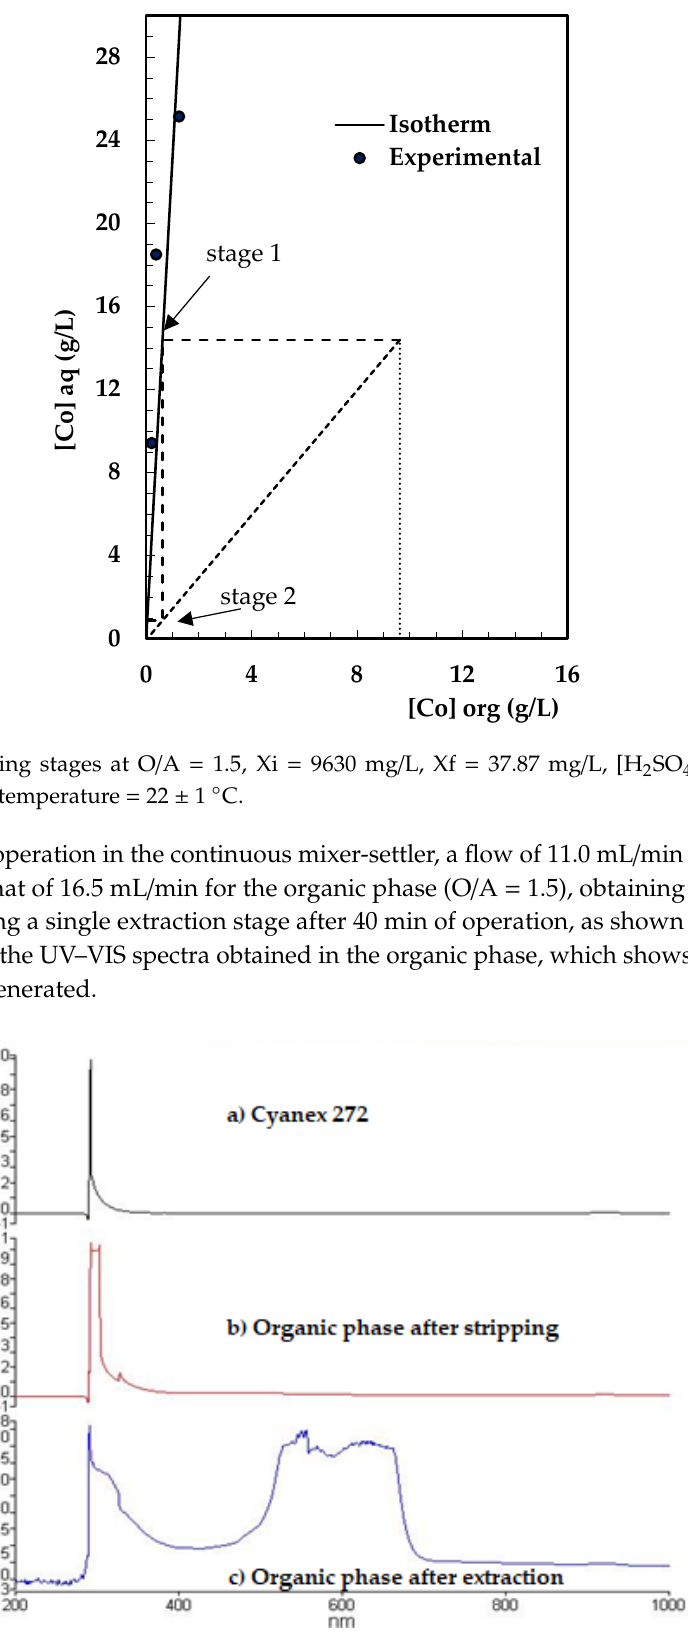
Figure 13. UV-VIS spectra: ( a ) Cyanex 272 in kerosene, ( b ) organic phase after stripping, and ( c ) organic phase complex cobalt–Cyanex 272 after extraction.